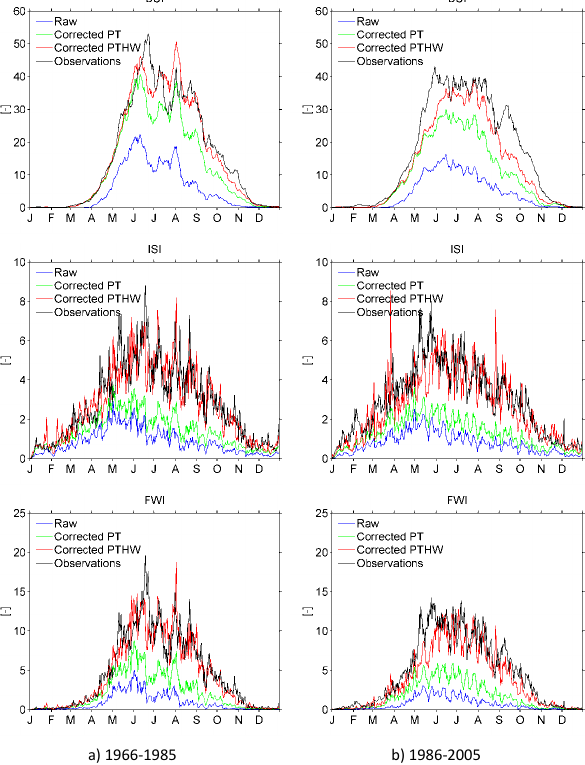
Figure 6. Seasonal variation of FFMC, DMC and DC index at the Edsbyn station (see Fig. 1). Comparison of values based on ob- servations (black line), raw output from climate model (blue line), RCA3-E5r3-A1B, corrected P (precipitation), T (temperature) and uncorrected RH (relative humidity) and W (wind speed) (green line) and corrected P (precipitation), T (temperature), RH (relative hu- midity) and W (wind speed) (red line) for period (a) 1966–1985 (calibration) and (b) 1986–2005 (validation). Note that the DC is in- fluenced by P (precipitation) and T (temperature) (see blue, green and black lines).